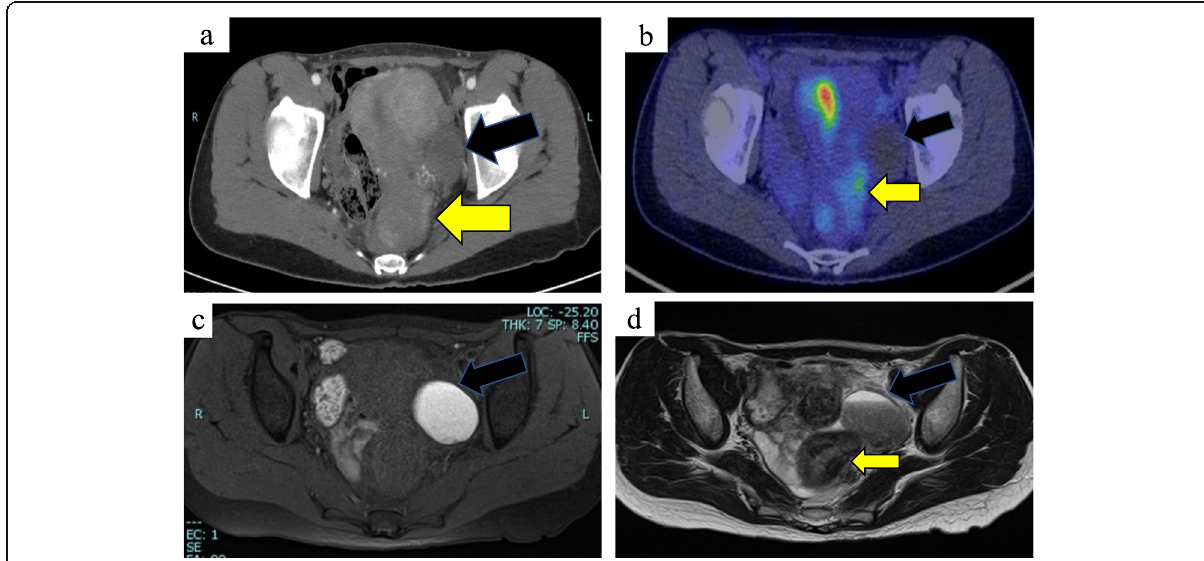
Fig. 2 Computed tomography and magnetic resonance imaging findings. Computed tomography revealed thickening of the rectal wall (yellow